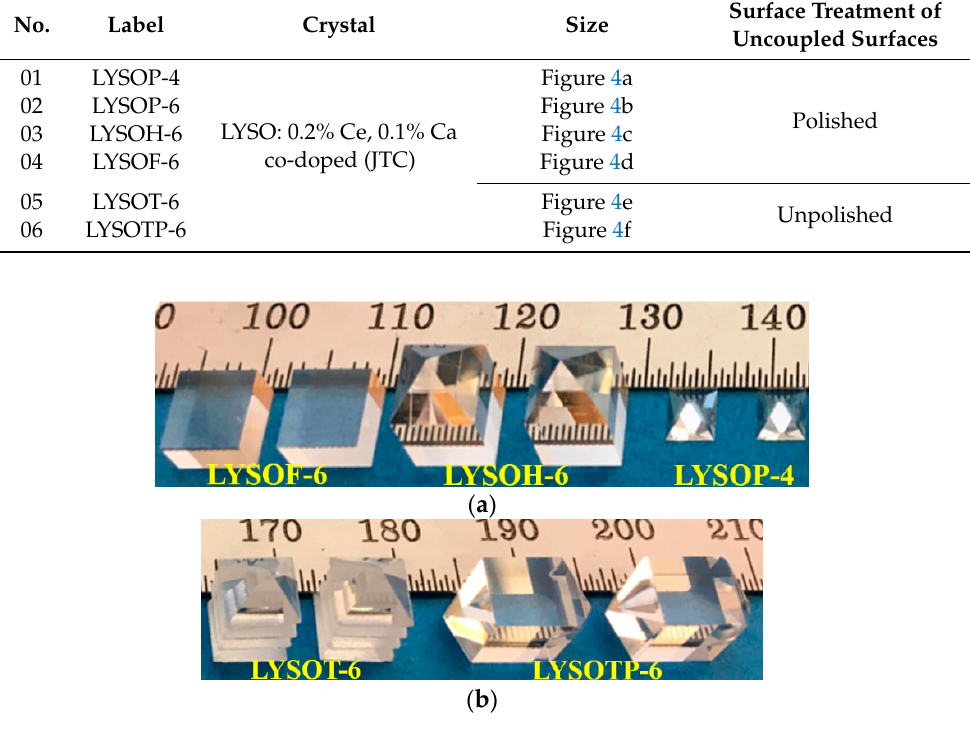
Figure 3. ( a ) LYSOF-6 (left), LYSOH-6 ( middle ) and LYSOP-4 ( right ) crystals; ( b ) LYSOT-6 ( left ) and LYSOTP-6 ( right ) crystals.